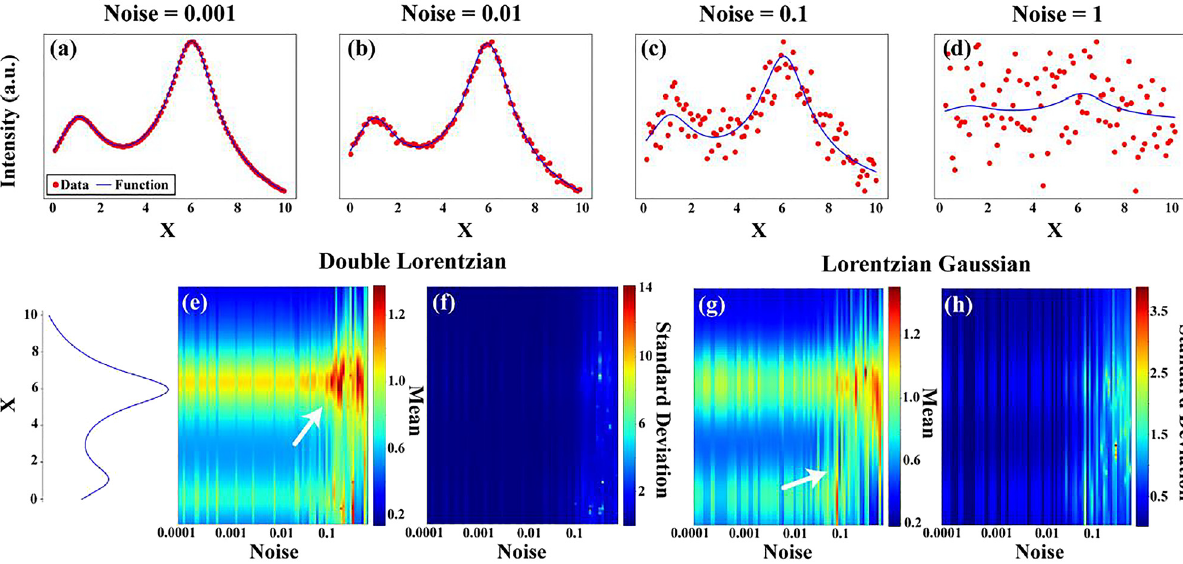
Figure4: (a – d)Demonstratehowasyntheticdatasetiscreatedutilizingaknownfunctionandacertainamountofnoiseisproduced.Shownin (e) and (f) is the fi tting of the Double Lorentzian model as a function of noise. As indicated by the arrow in (e), at a particular amount of noise, this model begins to fail at describing the dataset. Utilizing the Lorentzian-Gaussian model as shown (g) and (h), this fail point begins at a lower amount of